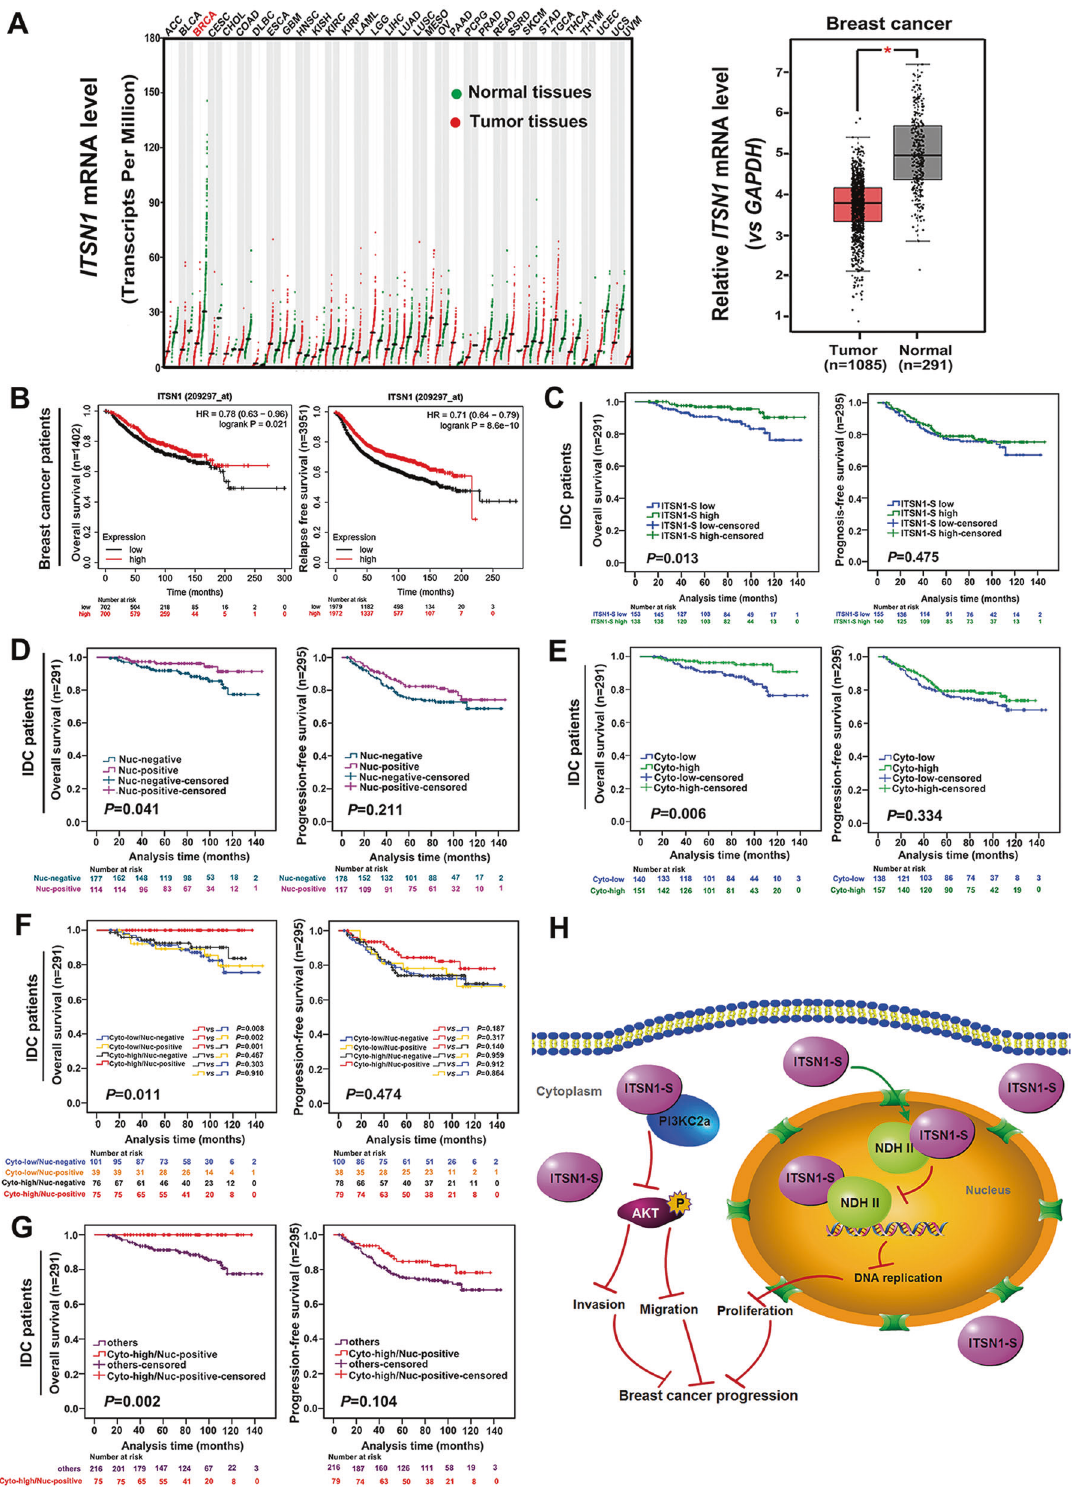
Statistical analysis The GraphPad Prism version 6.0 and the SPSS software Version 20.0 were used for statistical analysis. The nonparametric Spearman ’ s correlation analysis was used to assess the association between two variables. Survival outcomes were estimated using the Kaplan – Meier method and were compared between the groups by using log-rank statistics. Univariate and